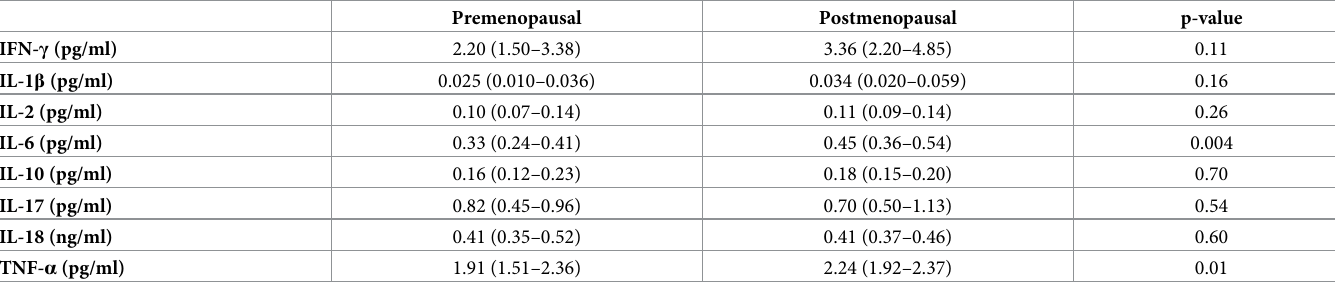
T-cell subsets were analyzed on 27 study participants. Postmenopausal women had a signifi- cantly higher number of circulating CD3+ lymphocytes (1,336 cells/ μ l (1,253–1,515) vs. 1,128 cells/ μ l (820–1,380), p = 0.04) compared to premenopausal women (Fig 1A). However, post- Table 4. Plasma cytokine levels in pre- and postmenopausal